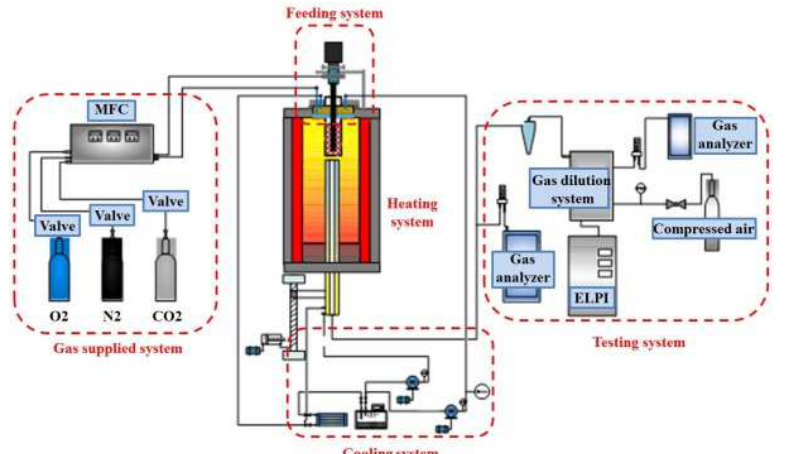
Figure 1. Schematic diagram of the experimental furnace. Table 1. Proximate and ultimate analysis of ZD coal. Proximate Analysis (wt.%, ad. = Air Dry Basis) Ultimate Analysis (wt.%, ad. = Air Dry Basis) M(Moisture) A(Ash) V(Volatile)